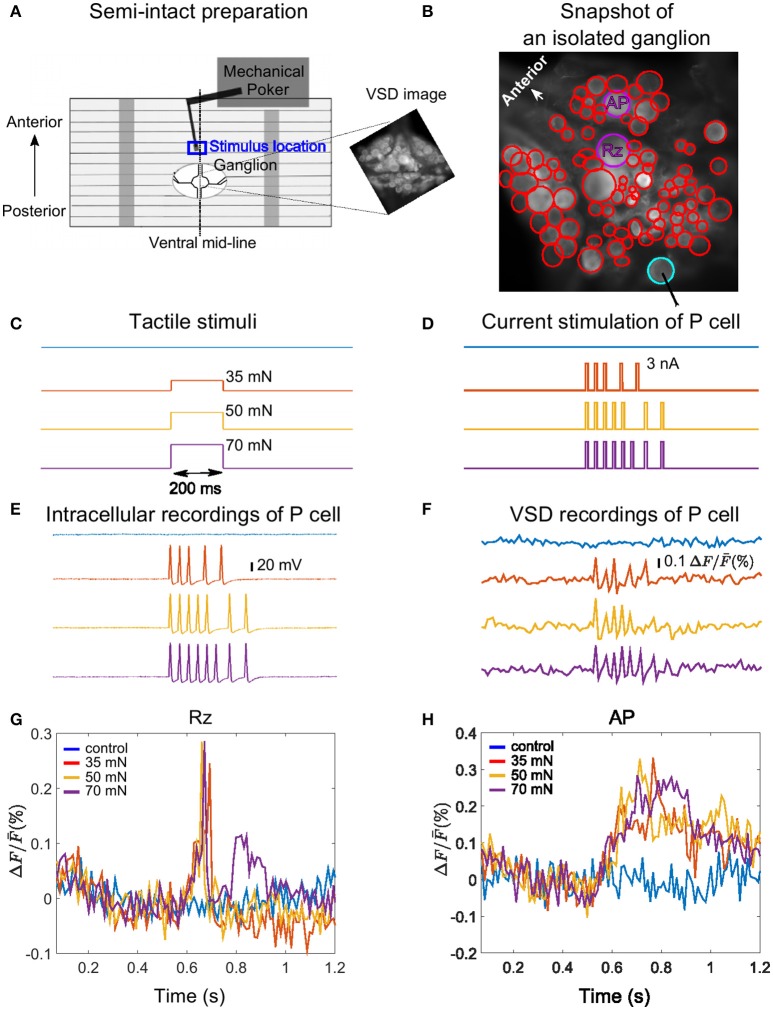
Experimental design, example VSD recording and cell responses. (A) Body-wall preparation of a leech ganglion (see Pirschel and Kretzberg, 2016). The skin was bisected on the dorsal mid-line of the body-wall and pinned ventral side up with a small hole allowing access to the ganglion. The tactile stimulus was presented to the 3rd annulus at the ventral mid-line (blue box), while the ganglion was imaged with VSD recordings. The right inset shows a frame of voltage-sensitive dye recording of the ganglion with the full resolution of the camera (512 × 512 pixels), covering approximately 1 × 1 mm2. (B) Snapshot image of an isolated midbody ganglion preparation taken with the full resolution of the camera (512 × 512 pixels). Circles depict regions of interest corresponding to cell bodies (red, purple and cyan). The cells were detected in two different layers of a stack, with the full resolution of the camera. The position of the stimulated P cell is indicated by the cyan circle, and the two cells for which responses are shown in panels G and H are marked by purple circles. (C) Tactile stimuli were applied for the duration of 200 ms with low (35 mN, red), medium (50 mN, yellow), and high (70 mN, purple) intensities. Responses were compared to control condition (blue). (D) Intracellular current pulses used to stimulate the P cell, mimicking responses to weak, medium and stronger intensities. The duration of each impulse was 10 ms. (E,F) Intracellularly evoked action potentials (E) and simultaneous VSD recordings (F) of the P cell in response to the intracellular current stimulation shown in (D). (G,H) Sample VSD signals of a Retzius cell (Rz) and an AP cell (both marked purple in B) show responses to spikes of the stimulated P cell (cyan in B, response traces in E,F).